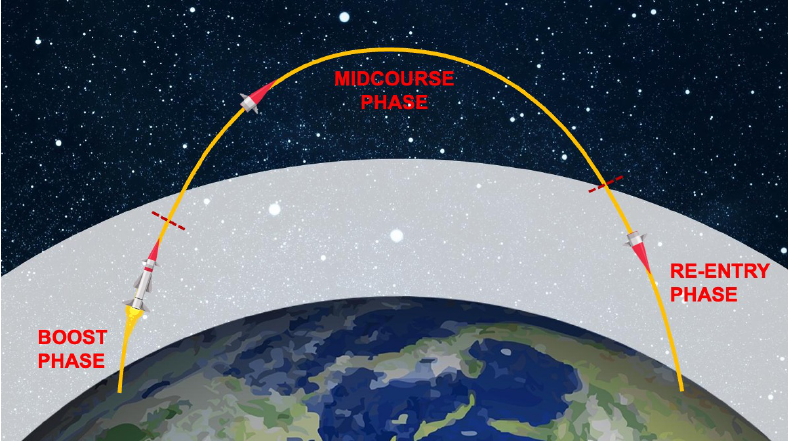
Figure 1. The trajectory and phases of the flight of a ballistic missile. Most of the time is spent outside the atmosphere (represented by the white area) and engines are used only during the boost phase. The red dashed lines represents the boundaries of the various phases.